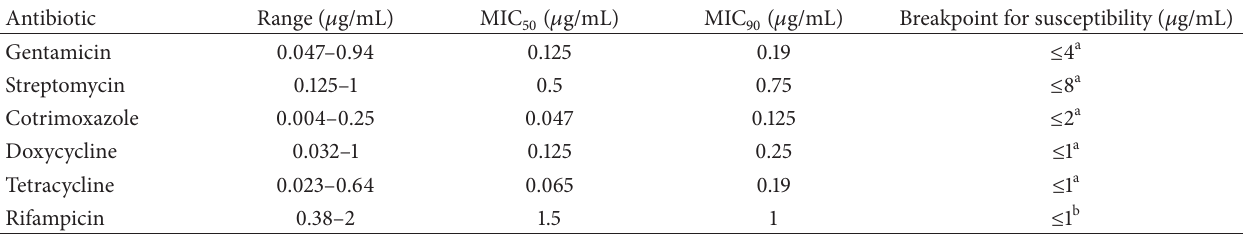
Table 1: MIC range and MIC 50 and MIC 90 values of antimicrobial